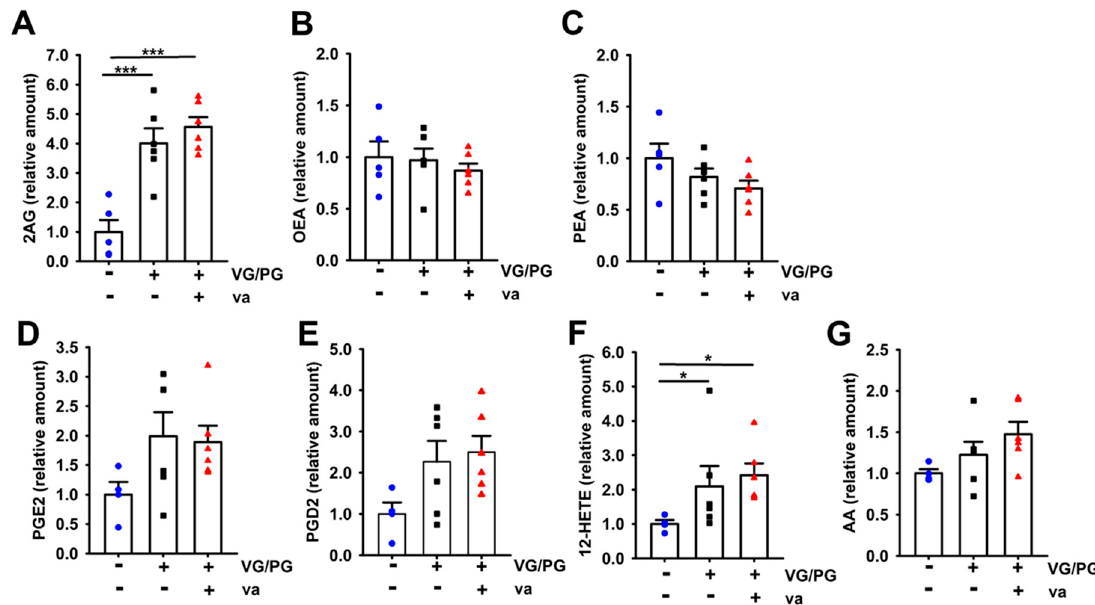
Figure 4. Inhalation of e-cig aerosols composed of 70%/30% VG/PG alone or with vanilla flavor affects the extracted amount of endocannabinoid and prostaglandins in the lungs. The right middle lung lobe was extracted for lipid mediators and quantified by LC-MS/MS using deuterated standards for mice exposed to air ( n = 5), VG/PG ( n = 6), and VG/PG ( n = 6) plus vanilla. 2-AG ( A ), OEA ( B ), PEA ( C ), PGE2 ( D ), PGD2 ( E ), 12-HETE ( F ), and AA ( G ) levels are pictured. AEA levels were too low to quantify. Data are expressed as mean ± SEM. Differences were analyzed by a one-way ANOVA (* p < 0.05, *** p < 0.001).